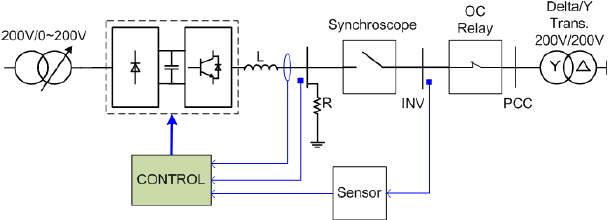
Figure 13. Experiment schematic for three-phase grid-connected